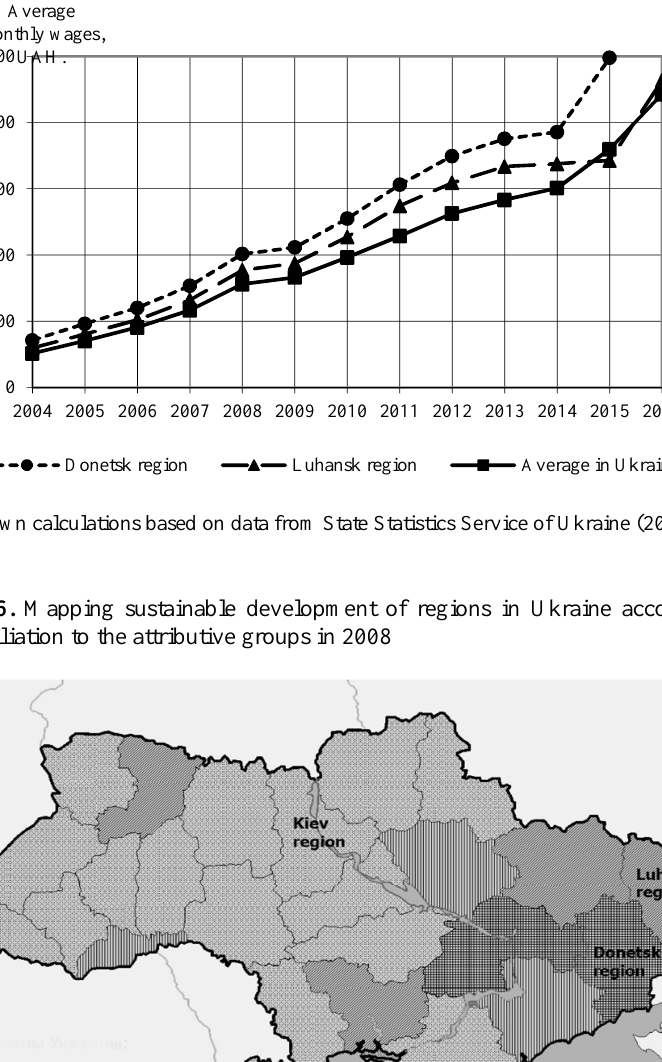
Figure 5. Dynamics of average monthly wages of Luhansk and Donetsk regions compared to average value in Ukraine